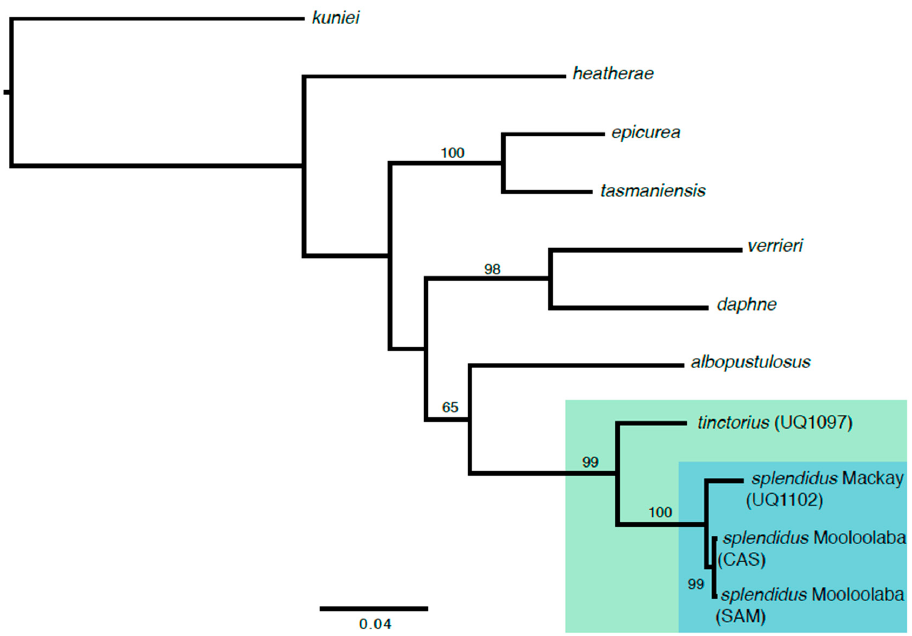
Figure 2. Maximum-likelihood topology for Cytochrome Oxidase I gene (COI) + 16S DNA from selected species of Goniobranchus nudibranchs. Specimens of G. splendidus shown in blue box, and sister species G. tinctorius shown in green box. Bootstrap values less than 60 are not shown.